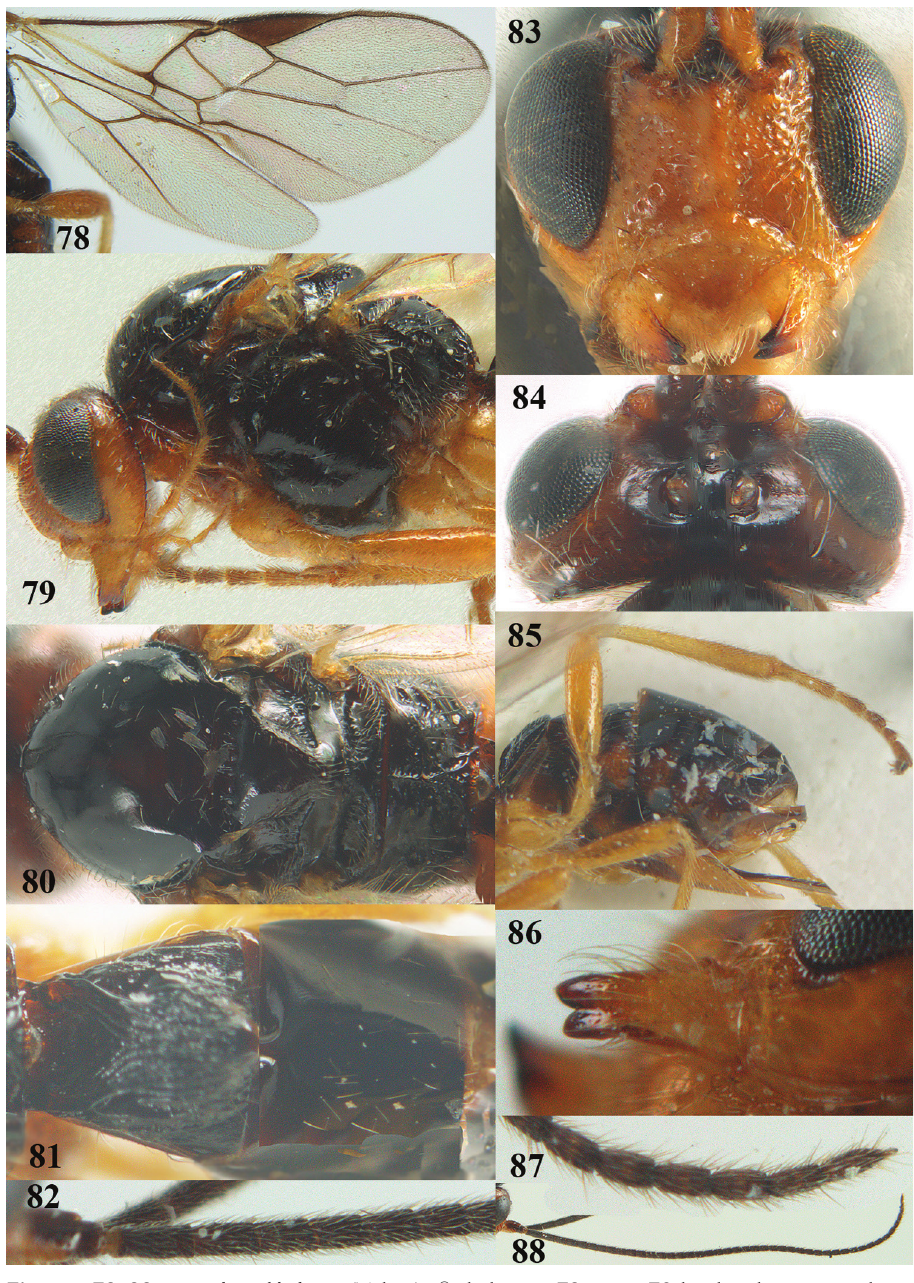
Figures 78–88. Psyttalia sakhalinica (Tobias), ♀ , holotype. 78 wings 79 head and mesosoma later- al 80 mesosoma dorsal 81 first–third metasomal tergites dorsal 82 base of antenna 83 head anterior 84 head dorsal 85 hind leg and hypopygium lateral 86 mandible lateral 87 apex of antenna 88